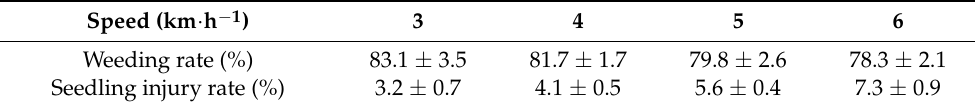
Table 5. Weeding rate and seedling injury rate at different working speeds of the machine.